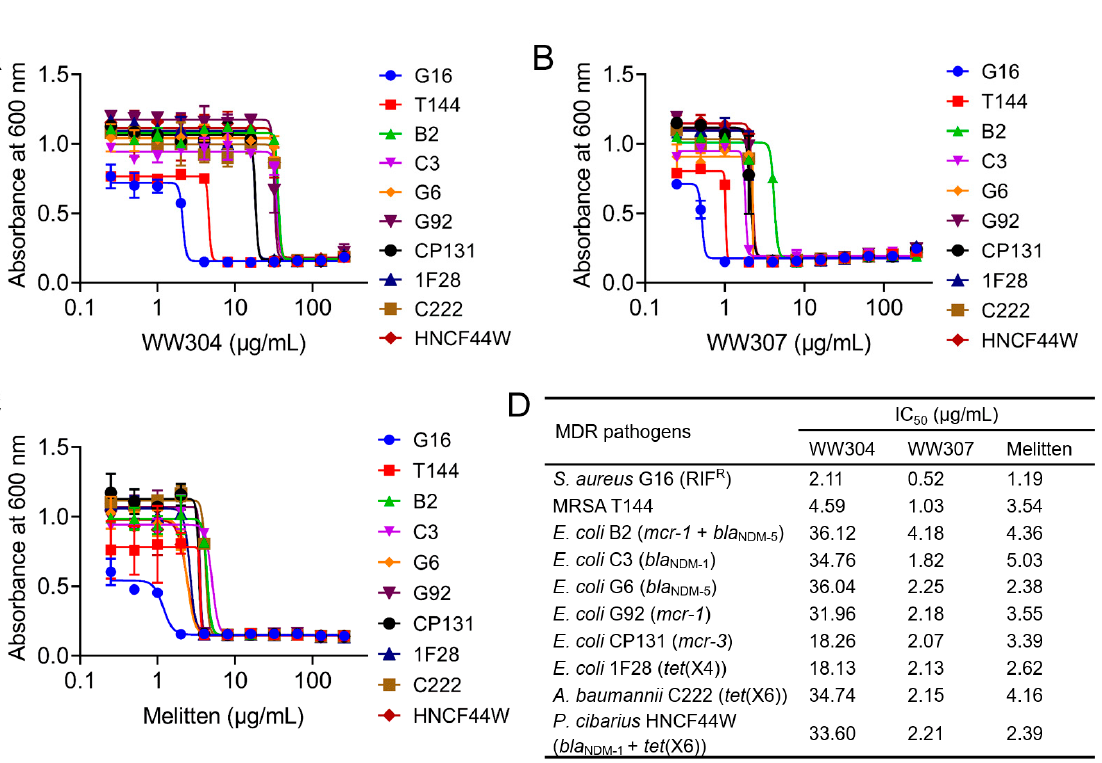
Figure 2. Half-maximal inhibitory concentrations (IC 50 ) assay of WW304, WW307, and melitten against 10 tested MDR pathogens. Dose response curves ( A – C ) and IC 50 values ( D ) of WW304, WW307, and melitten on tested Table 2. Antimicrobial activity of amphiphilic peptides against a panel of MDR pathogenic bacte ‐ ria (MIC, μ g/mL).